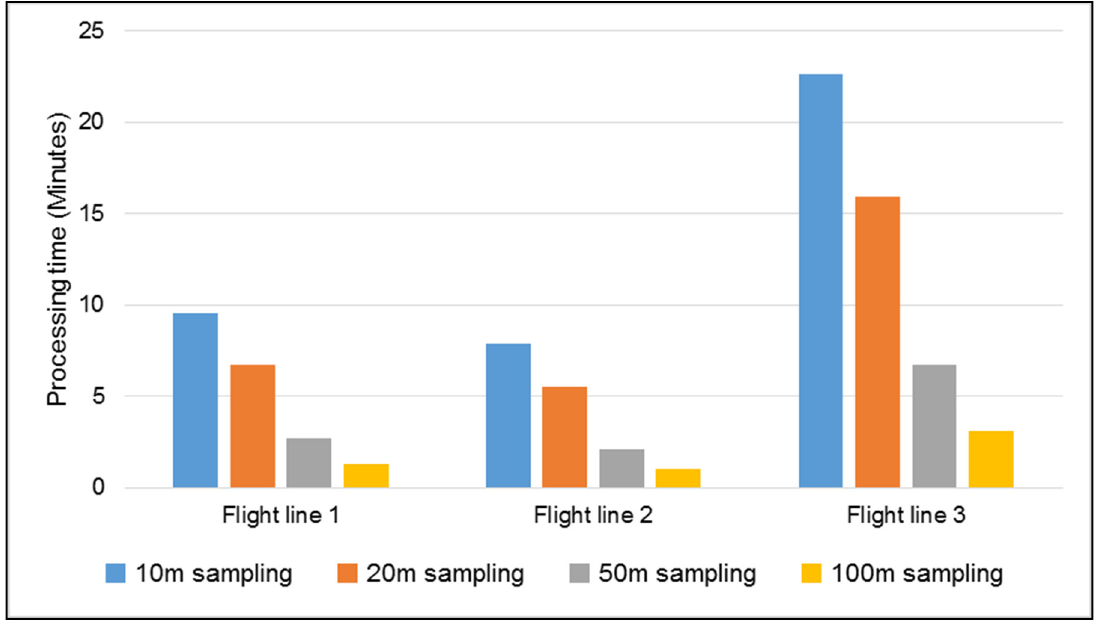
Figure 7. A comparison of CPU processing times for four different sampling intervals (10, 20, 50, and 100 m) for each of the three different flight-lines. Time differences between flight-lines are due to differences in data volumes/flight-line. Time differences within flight-lines are due to the sample size required to be